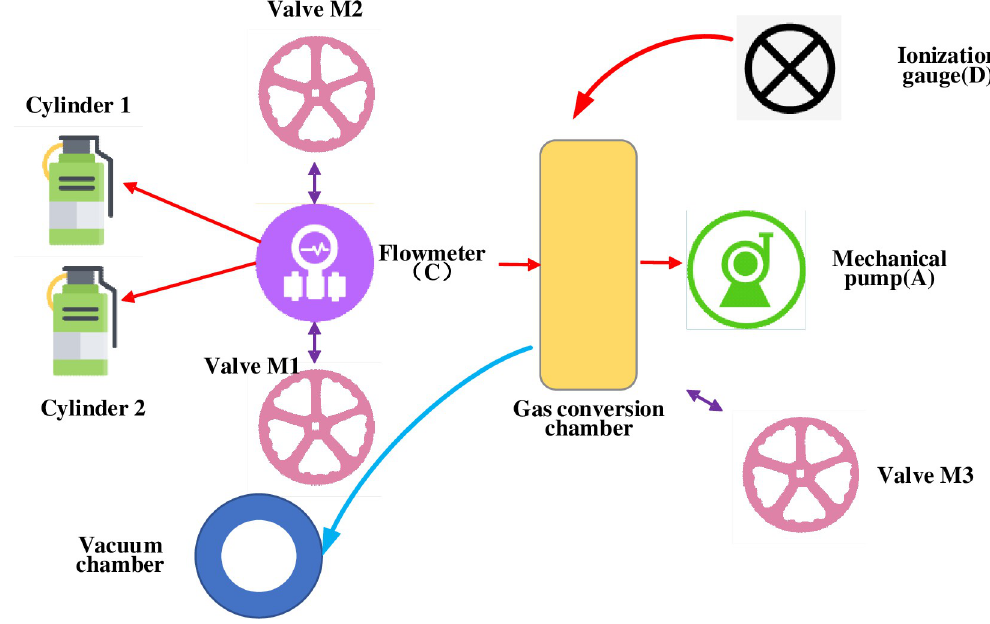
Fig 4. A schematic diagram of FS-based black silicon processing vacuum